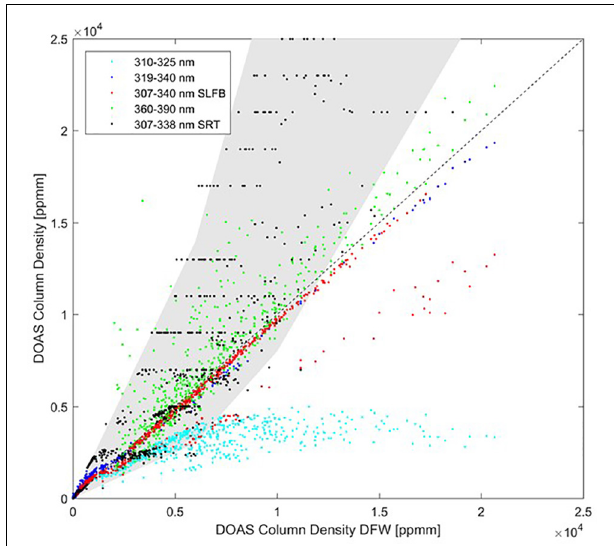
FIGURE 8 | SO 2 column densities obtained from ten road traverse measurements on Crater Rim Drive on 03 March 2017 between 10:50 and 11:55 HST. Column densities were evaluated with 6 different retrieval methods. In this plot, all column densities are plotted against the results obtained using a Dual Fit Window (DFW) approach that is equivalent to the spectral analysis procedure used to evaluate FLYSPEC mobile or upward looking array